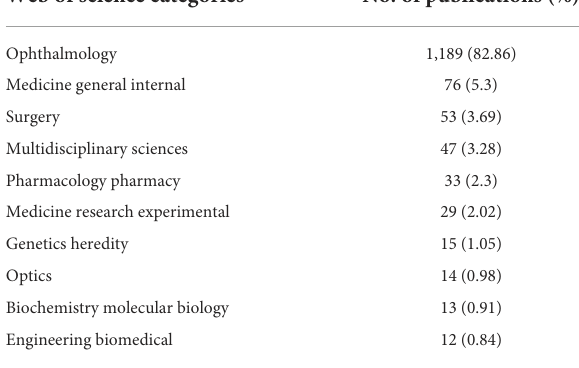
TABLE 2 Top 10 Web of Science categories of journals on pathologic myopia research.